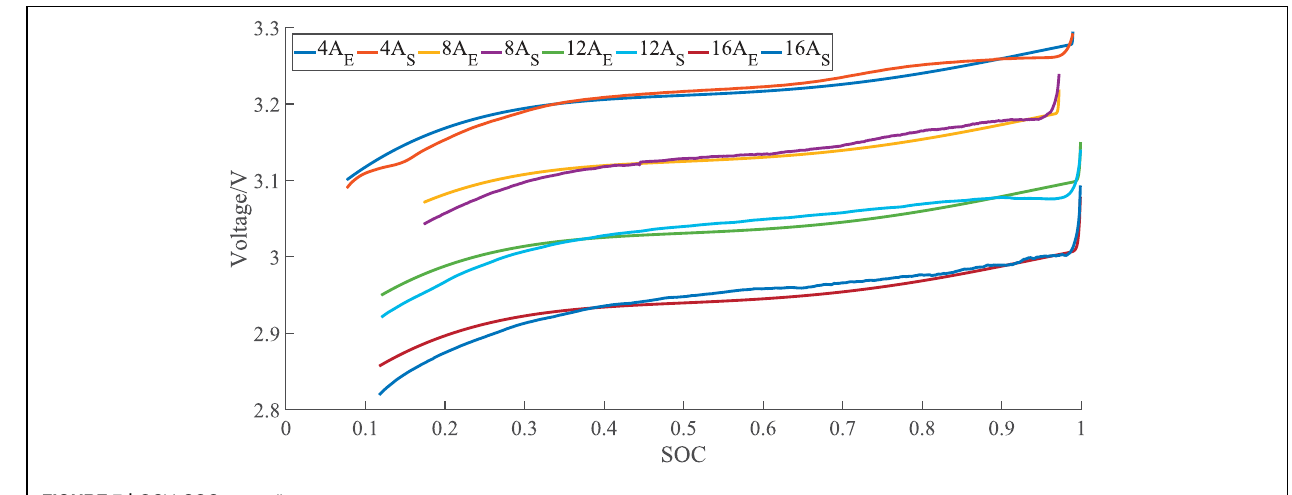
FIGURE 7 | OCV – SOC curve diagram.